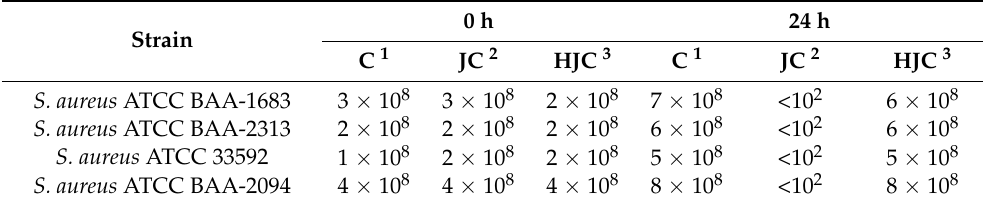
Figure 3. ( A ). SEM images of intact S. aureus 8325-4 cells. ( B – D ). Co-aggregation of LF3872 cells with S. aureus 8325-4 cells; destruction of cell wall and death of the pathogen. Note: the ratio of S. aureus 8325-4 cells/ LF3872 cells is 1/10. Table 1. Antagonistic activity of LF3872 against a collection of the ATCC methicillin-resistant S. aureus